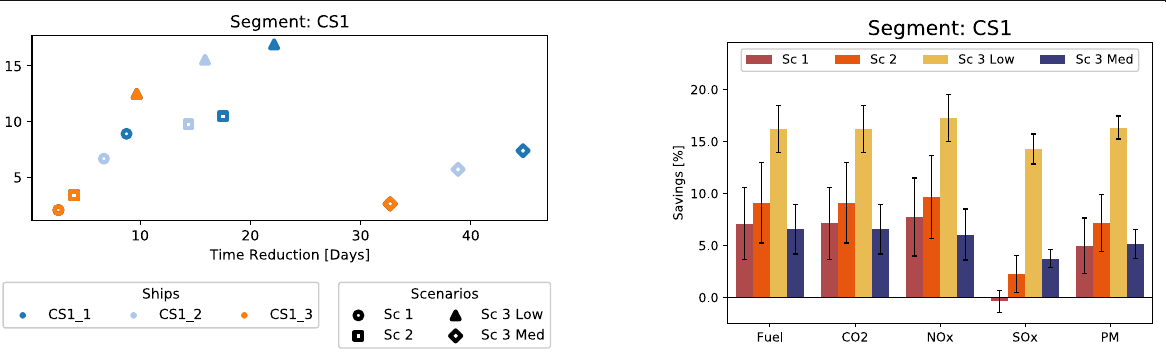
Fig. 8 (left) Results for CS1 ships. Markers indicate the scenario, colors the ship. CS1 ships can benefit of STM not only thanks to synchronization but also thanks to a reduction in congestion in places like the Kiel Canal. Potential reductions of 10 – 20 days of navigation and more than a 15% of fuel and GHG emissions are achievable. A summary of the savings per pollutant and scenario is presented on the right-hand-side